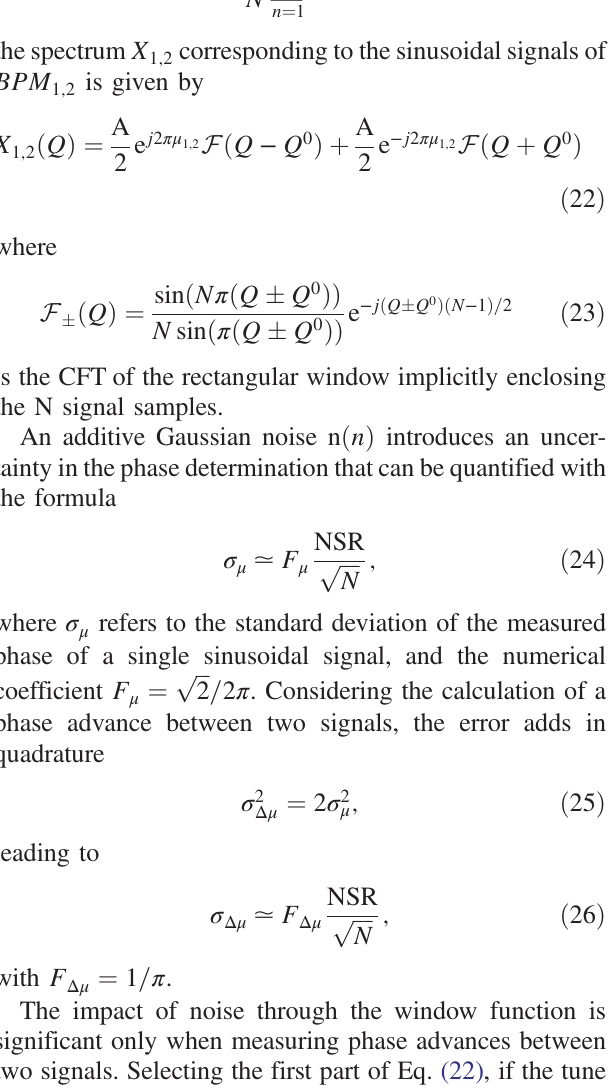
FIG. 5. Uncertainty in the tune determination with NAFF, FFT and SUSSIX versus number of turns calculated up to N ≃ 10 4 turns considering amplitude Gaussian noise of NSR ¼ 5% . Dots are the simulated data, lines are the fits. SUSSIX and NAFF both implement a hanning